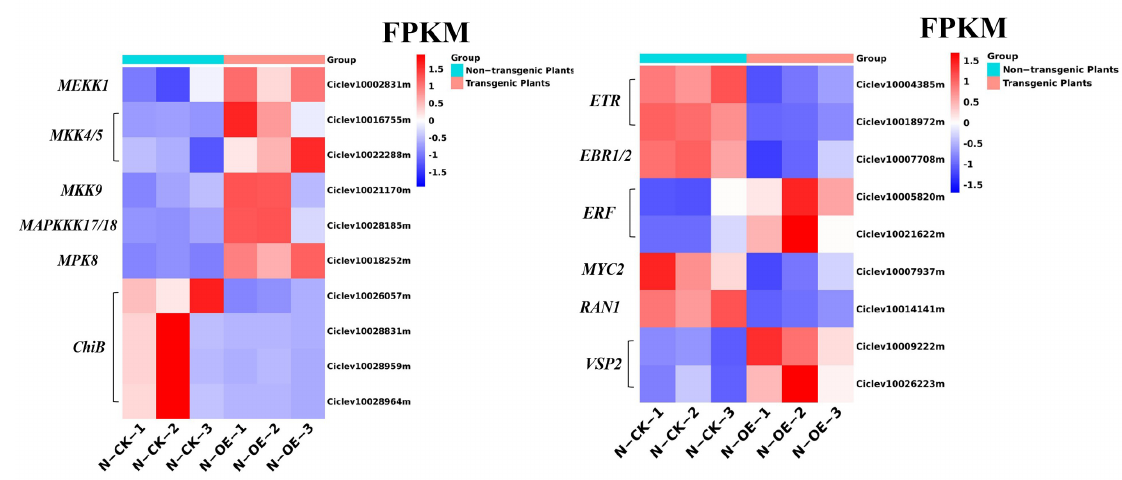
Figure 9. The FPKMs of the DEGs in the MAPK pathway in the non-transgenic plants versus the transgenic